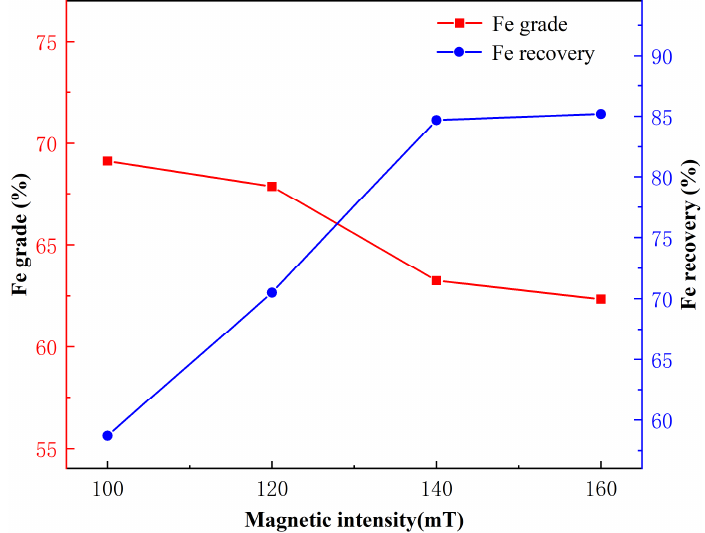
Figure 15. The effect of magnetic intensity on iron magnetic